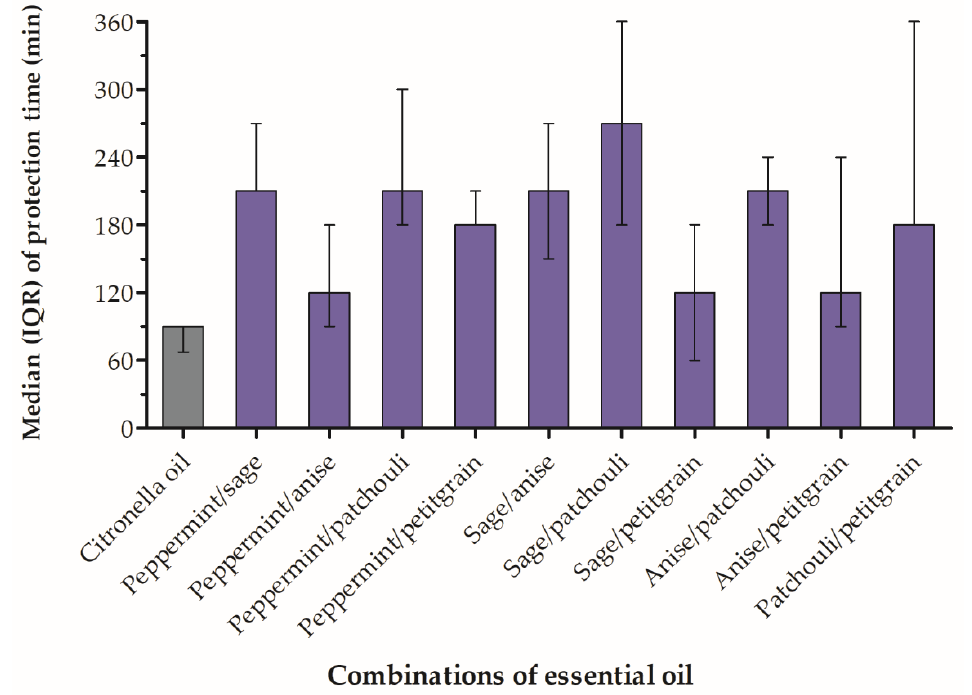
Figure 3. Median with interquartile range (IQR) protection times of essential oil combinations and citronella (control) against Anopheles dirus .